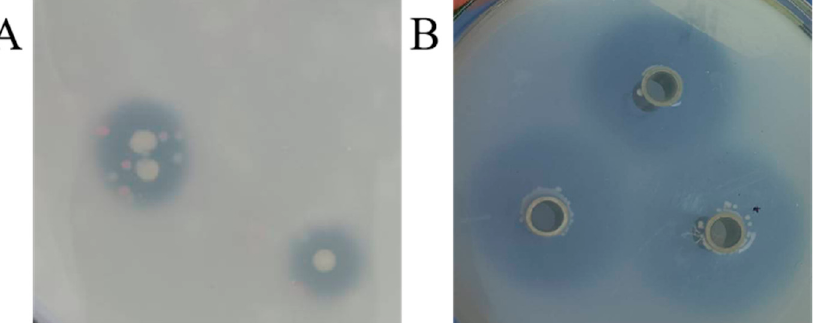
Figure 1. Clear circles produced by degradation of ethyl 4-hydroxy-3-methoxycinnamateas by the FAE strain ( A ), and clear circles produced by degradation of ethyl 4-hydroxy-3-methoxycinnamateas by the crude enzyme solution of FAE produced by strain ( B ). Table 1. Clear circles produced by the FAE producing strain. Strain No. Diameter of Clear Circles (mm) Strain No.